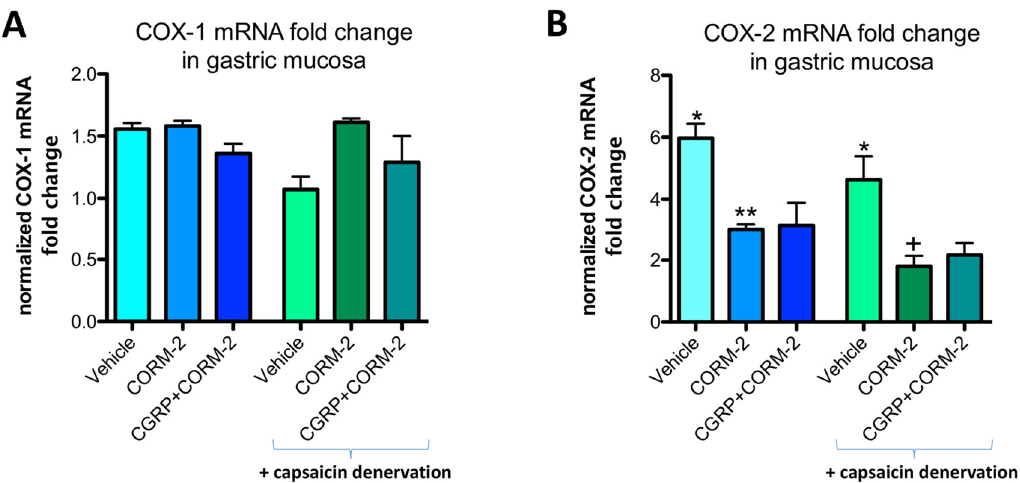
Figure 7. COX-1 ( A ) and COX-2 ( B ) mRNA fold change in gastric mucosa of rats pretreated with vehicle or CORM-2 (5 mg/kg i.g.) alone or with CGRP- α (10 µ g/kg i.p.) followed by i.g. administration of 75% ethanol with or without capsaicin denervation. Results are expressed as mRNA fold change of COX-1 and COX-2 normalized to succinate dehydrogenase complex, subunit A (SDHA) and β -actin. Results are mean ± SEM of 4–5 rats per each experimental group. Asterisk indicates significant change as compared with intact rats ( p < 0.05); double asterisks indicate significant difference as compared with vehicle-pretreated group without capsaicin denervation ( p < 0.05); cross indicates significant change as compared with vehicle-pretreated group with capsaicin denervation ( p < 0.05).